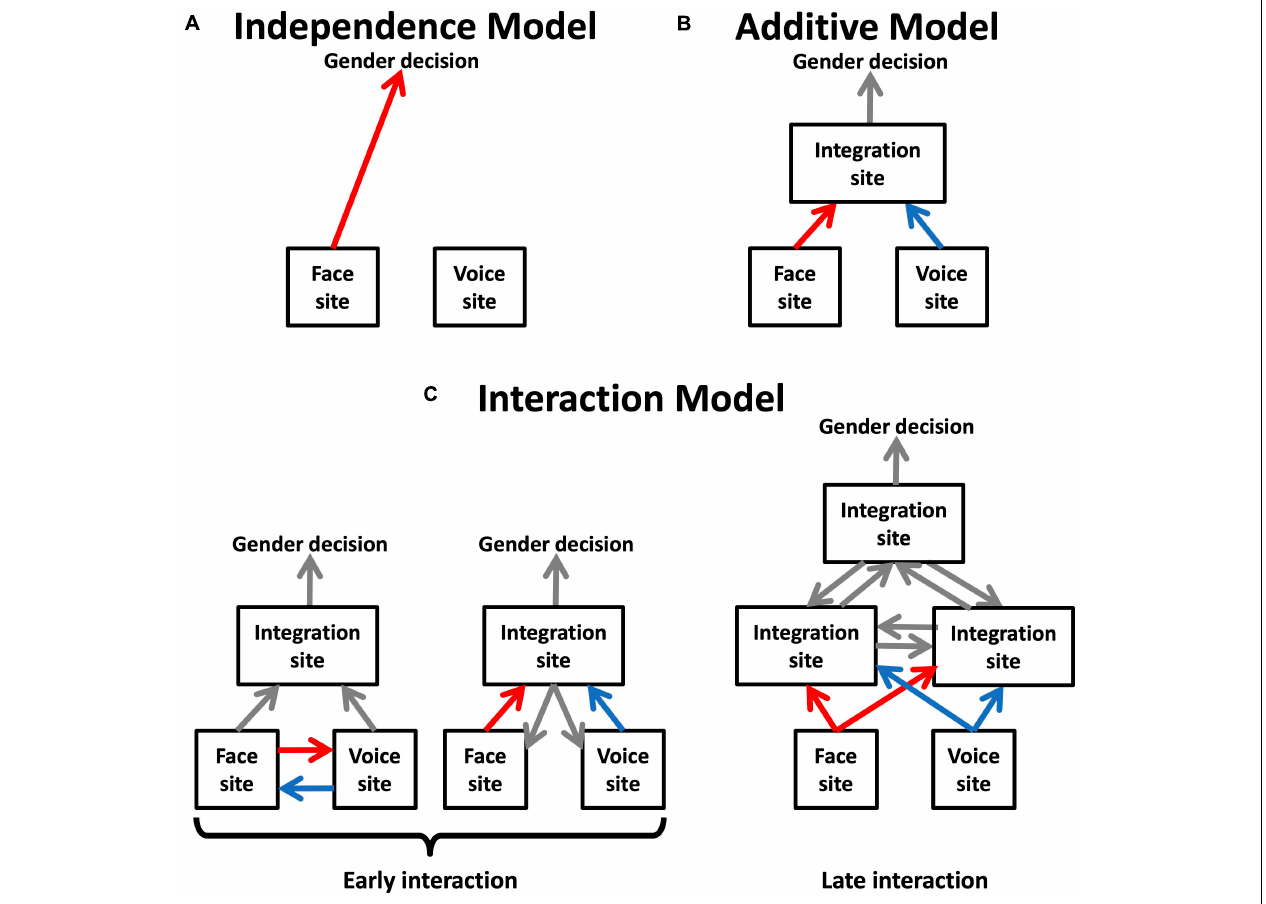
FIGURE 3 | Functional models suggested by MLCM models for face-voice gender integration. (A) The independence model supports a direct link between unimodal face and voice sites and the site of gender decision. (B) The additive model implies the existence of at least one mandatory site of multimodal integration prior to gender decision. (C) The saturated model is compatible with several interpretations that can be divided in two groups depending on whether the non-additive interaction involves unimodal areas or takes place exclusively at a higher